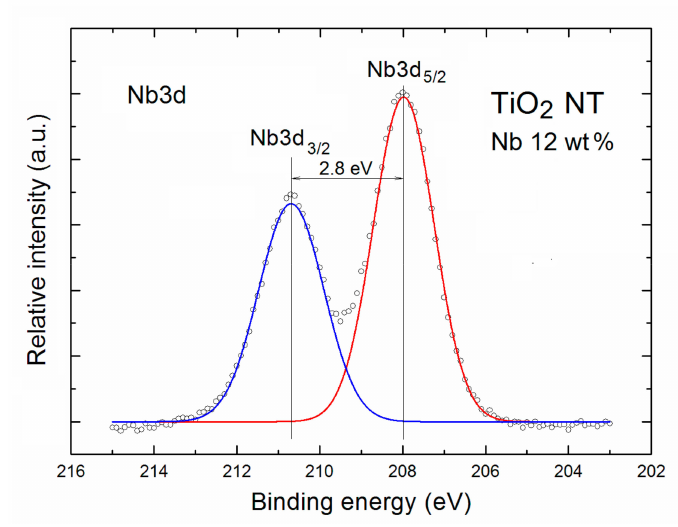
Figure 3. XPS Nb3d spectral line of Nb-doped TNT after Gauss deconvolution. The circles correspond to the experimental curves after linear smoothing, whereas the color lines correspond to the respective spin orbit